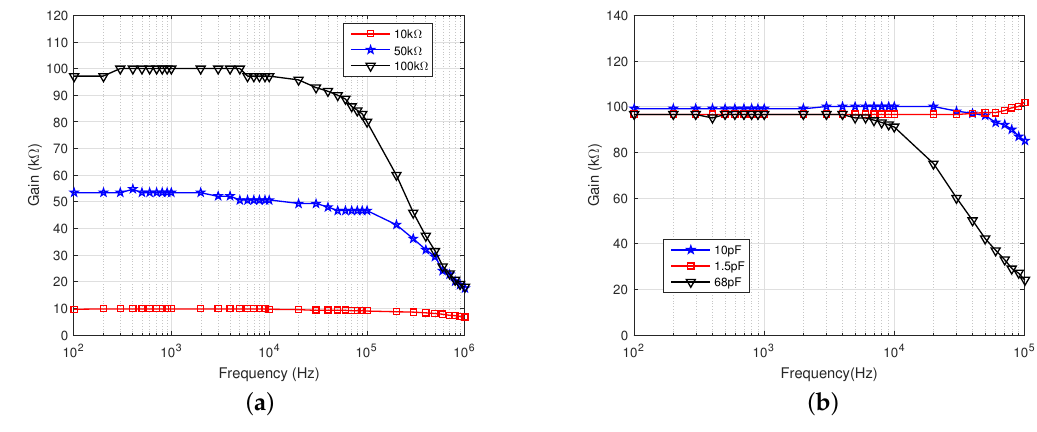
Figure 11. Measured frequency response of the TIA for ( a ) different gain settings and ( b ) different feedback capacitor values at a gain of 100 k Ω .